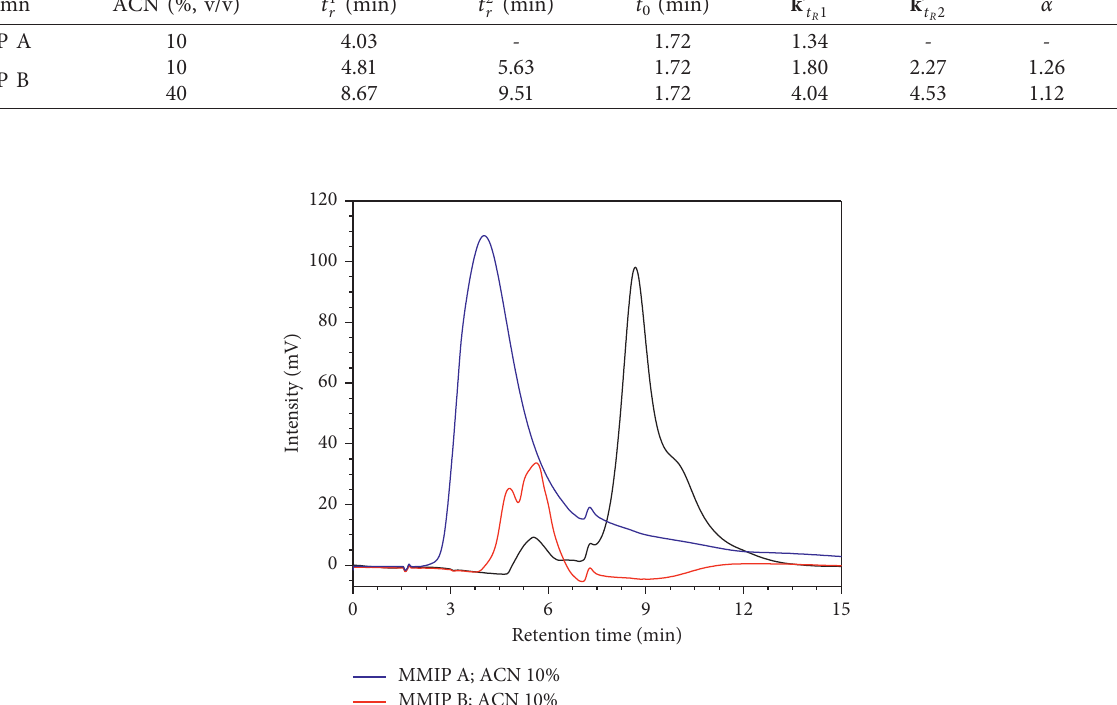
Table 5: Enantiomer separation with a variation in mobile phase composition on monolithic columns prepared with a different crosslinker. Column